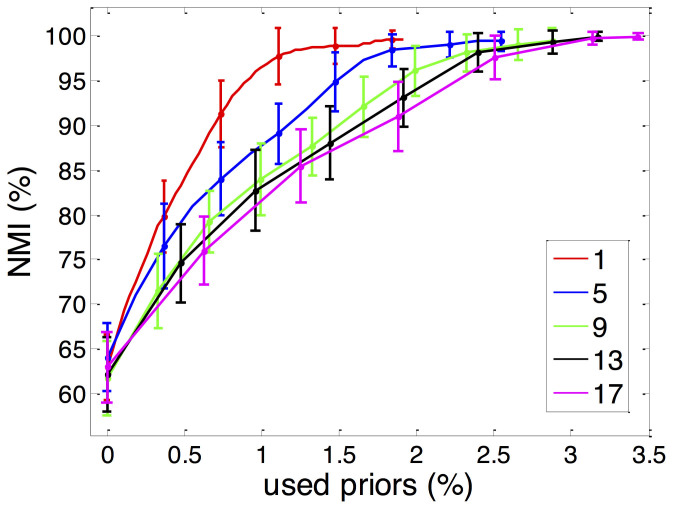
The impact of parameter nselect on the performance improvement.